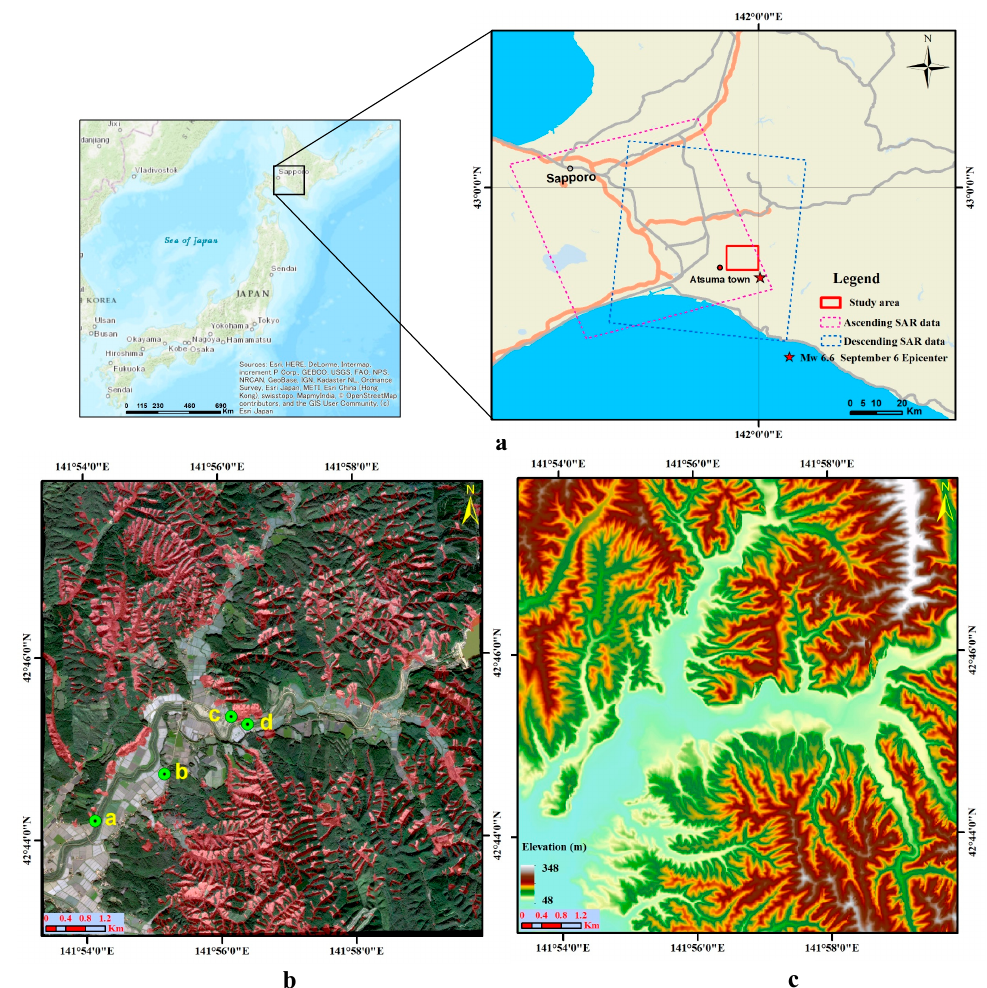
Figure 1. Map of the study area in Hokkaido, Japan: ( a ) the geographic location of the study area; ( b ) landslide areas identified by the GSI, Japan [23]; ( c ) the topography of the study area [28].